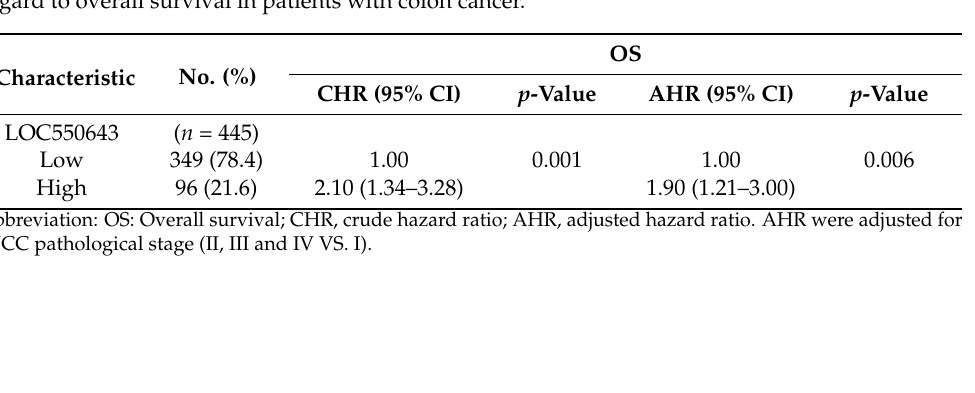
Table 2. Univariate and multivariate Cox regression analyses of LOC550643 gene expression with regard to overall survival in patients with colon